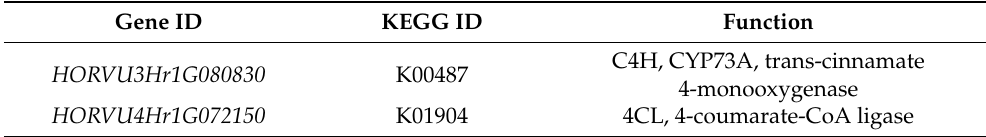
Table 3. Positive selective genes involved in phenylpropanoid